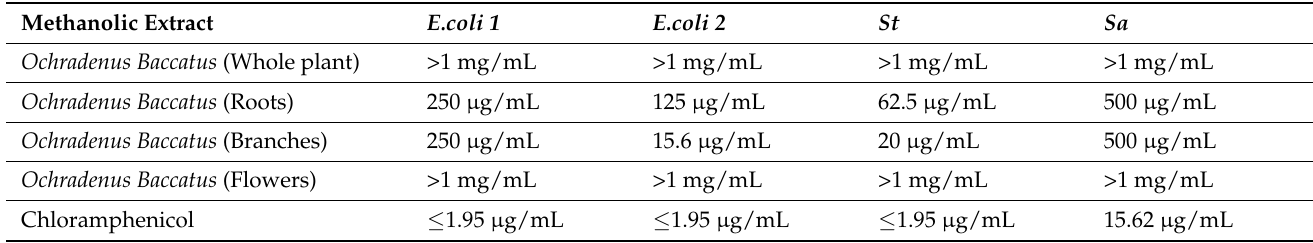
Table 1. Antibacterial activity of the O. baccatus extracts.